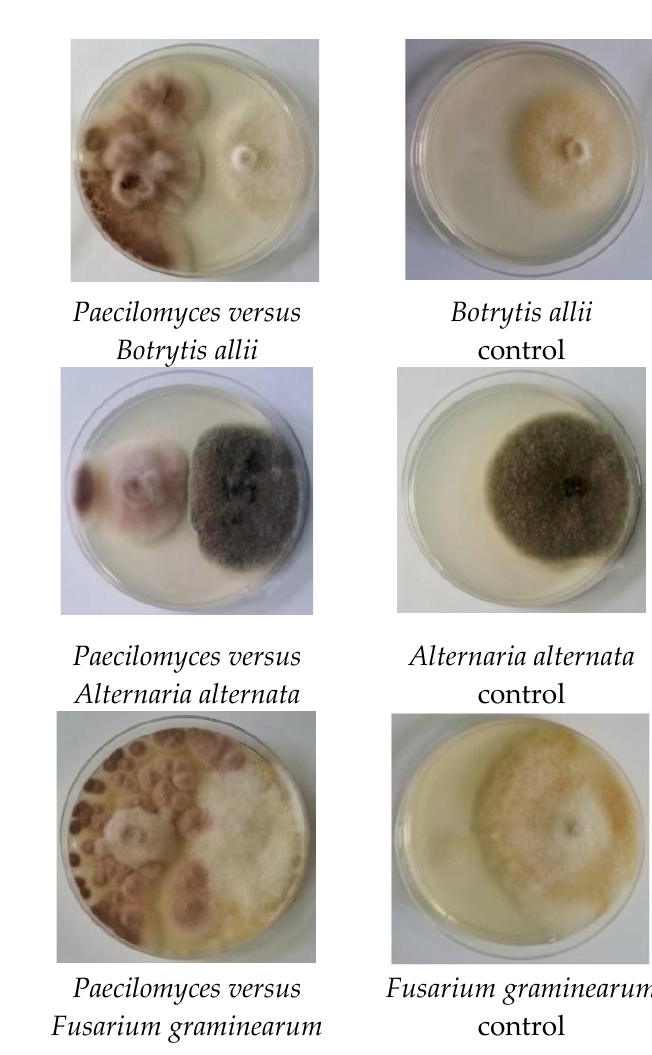
Figure 2. Illustration of the antagonism of Paecilomyces lilacinus 112 versus plant pathogenic fungi. Table 1. Interaction of Paecilomyces lilacinus 112 with tested pathogens.